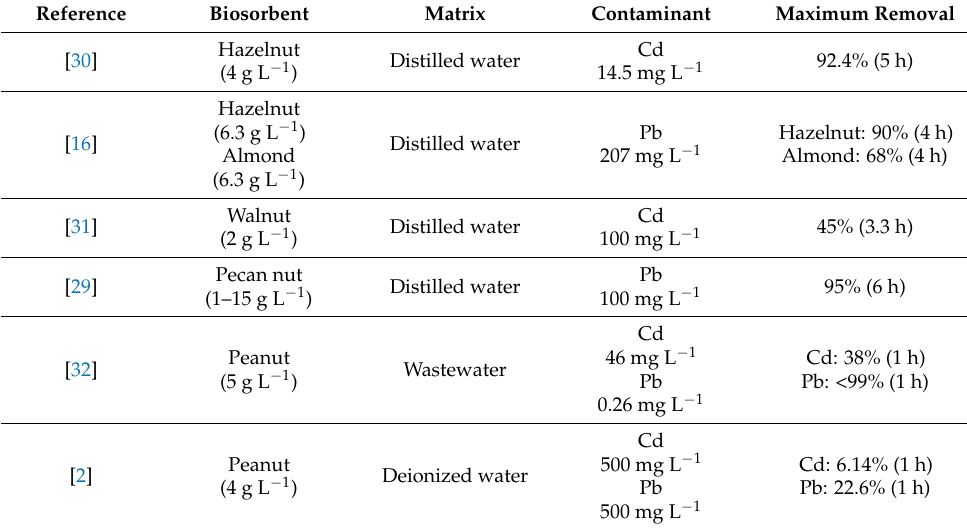
Table 6. Main experimental conditions of studies using nutshells as biosorbents to remove Cd and Pb from contaminated